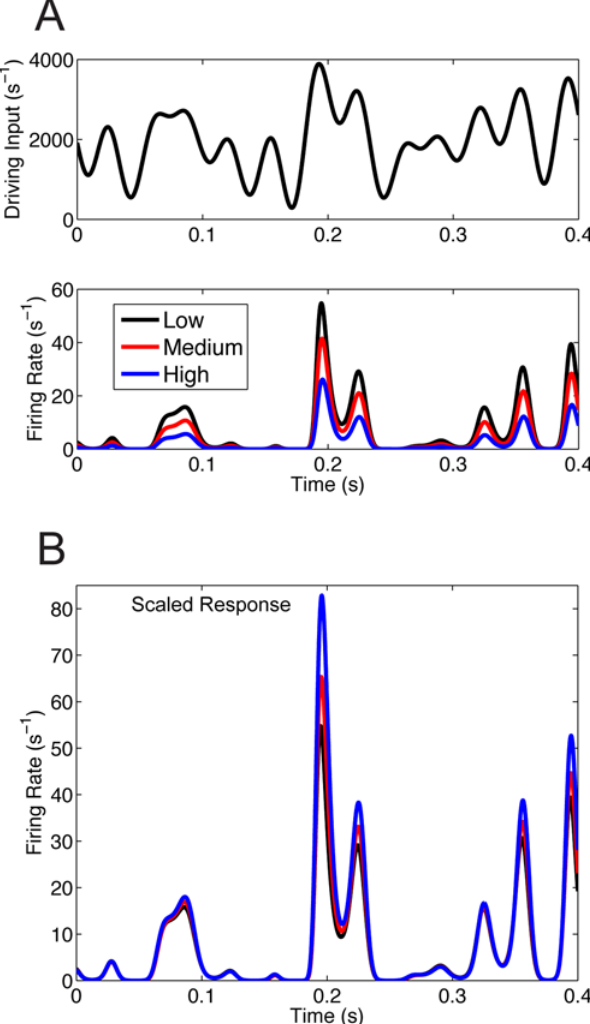
Figure 5. Divisive gain modulation does not hold for high intensity input drivers. (A) Top Panel: Same stimulus in Figure 3, but magnified to include higher output firing rates. Bottom Panel: The response for different balanced background levels n 0 responses do not scale in a simple )are the same , n 0 e i scaling parameter, and m is a parameter that insures n d t ð Þ in positive and not too small. Notice a ~ 1 corresponds to the driver input in Fig. 3A, and a ~ 1 : 8 with m ~ 1550 s { 1 corresponds to the driver input in Fig. 5A. The vertical dot-dashed line in black corresponds to 0 error because it is the reference background curve for a given a . The two points marked by stars (*) in Fig. 6A at a ~ 1 and n 0 1900 s 2 1 correspond to the difference in area between the curves in Fig. 3D, which is quite small. In fact, for a large region of parameter space, divisive gain modulation holds (any patch that is orange to blue in Fig. 6A). The two black circles ( N ) in Fig. 6A at a ~ 1 : 8 and ~ 1400 , 1900 s 2 1 correspond to the difference in area between n 0 i the curves in Fig. 5B. With larger a values, the neurons are in the drift dominated regime, and divisive gain modulation no longer holds, as expected (red regions in Fig. 6A). The average (unscaled) time-dependent response of the neurons with the same parameters and driver inputs as Fig. 6A are plotted in Fig. 6B on a logarithmic scale: